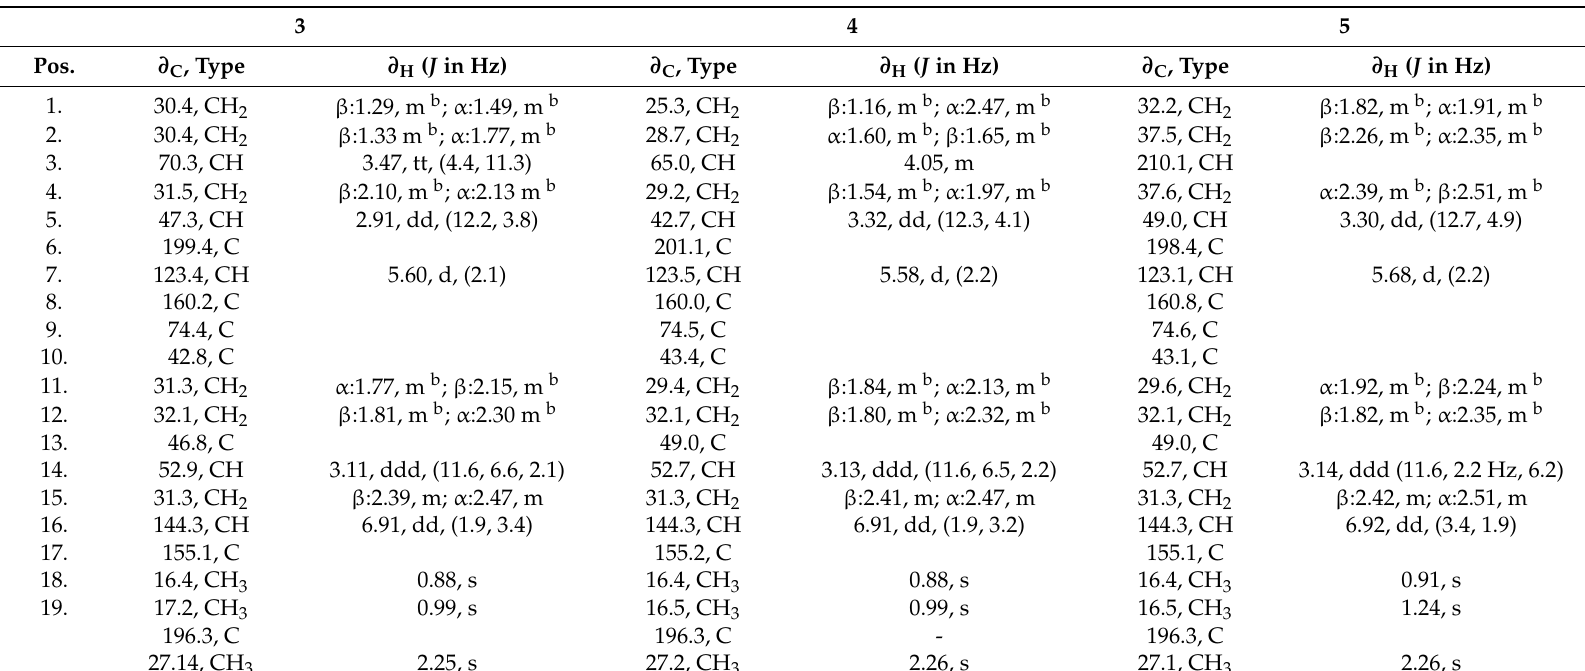
Table 2. NMR data for compounds 3 – 5 in acetone- d 6